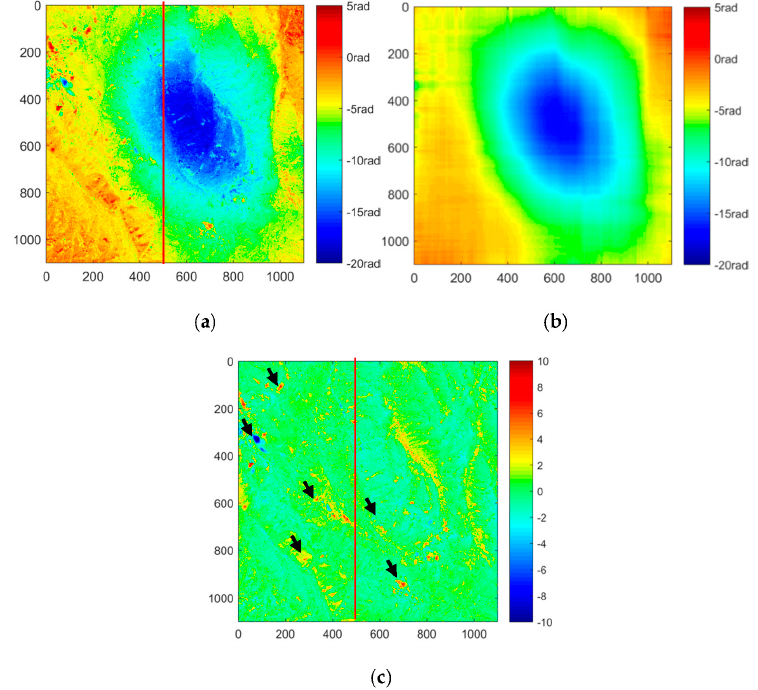
Figure 5. ( a ) Unwrapped deformation phase; ( b ) phase fitted with a fourth-order polynomial, showing the large area coseismal deformation; and ( c ) phase difference between ( a , b ).